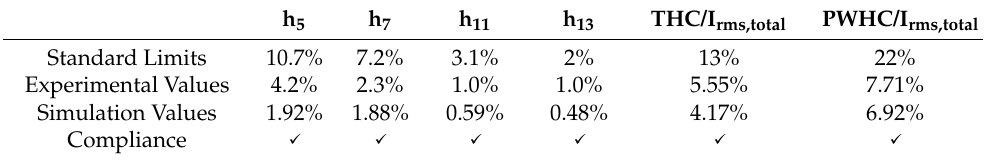
Table 4. IEC 61000-3-12 compliance study: Harmonic emission analysis in simulation and in practice.